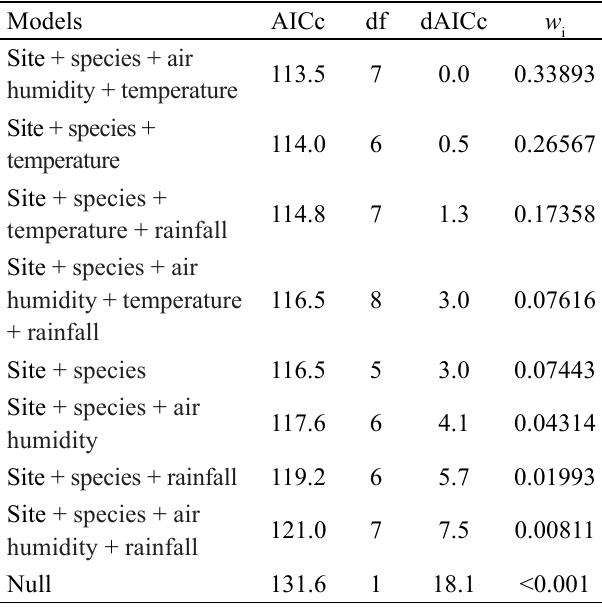
Table 5 . Summary of generalized linear models with Poisson distribution, which describe the relationship between number